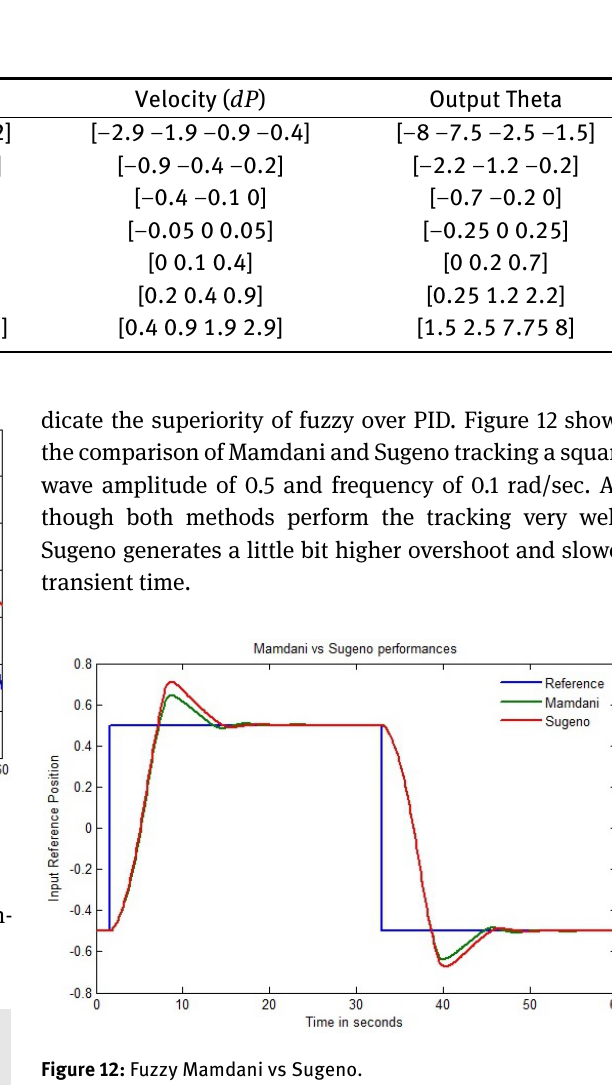
Figure 12: Fuzzy Mamdani vs